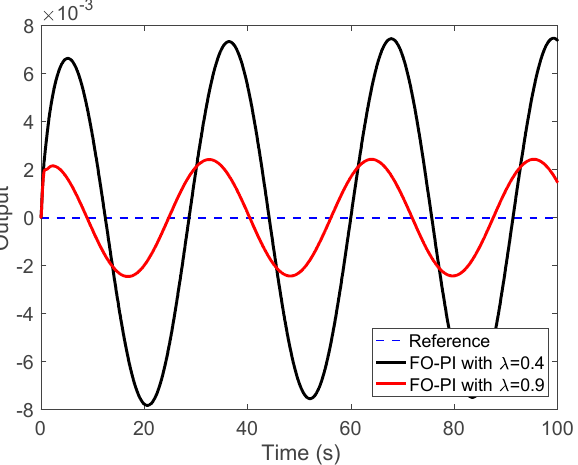
Figure 5. Disturbance rejection results for two different FO-PI controllers for a 0.2 rad/s disturbance frequency.